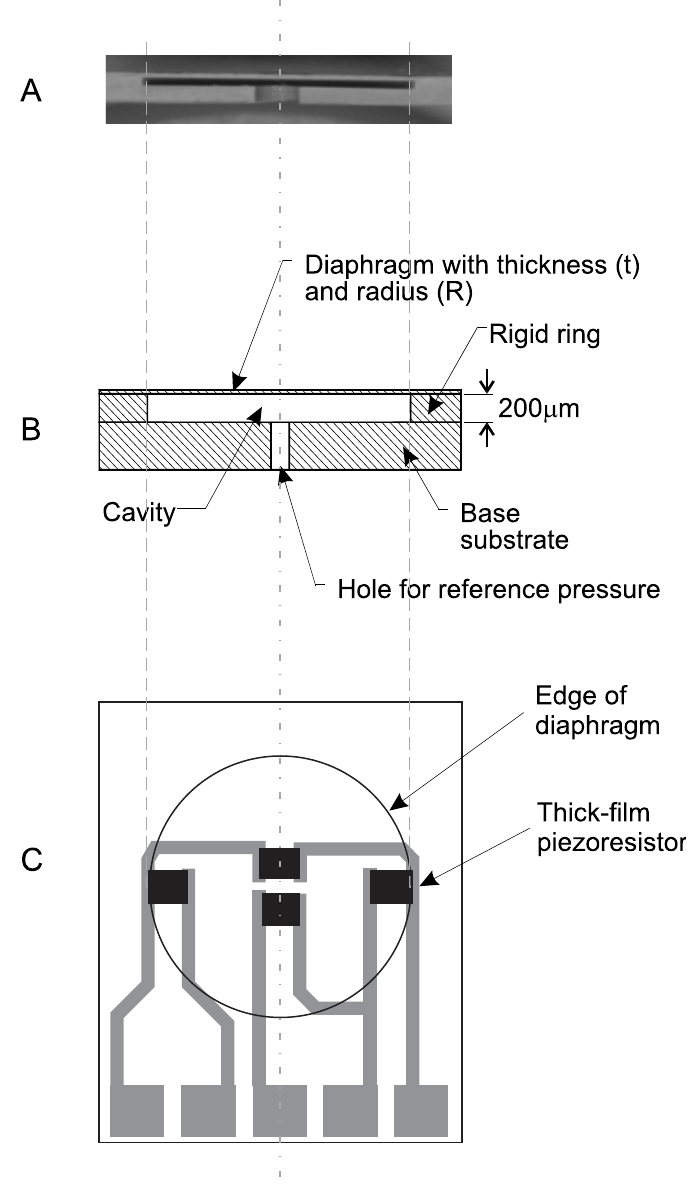
Figure 1. Photograph (a) , cross-section (b) and top-view (c) of the construction of a LTCC pressure